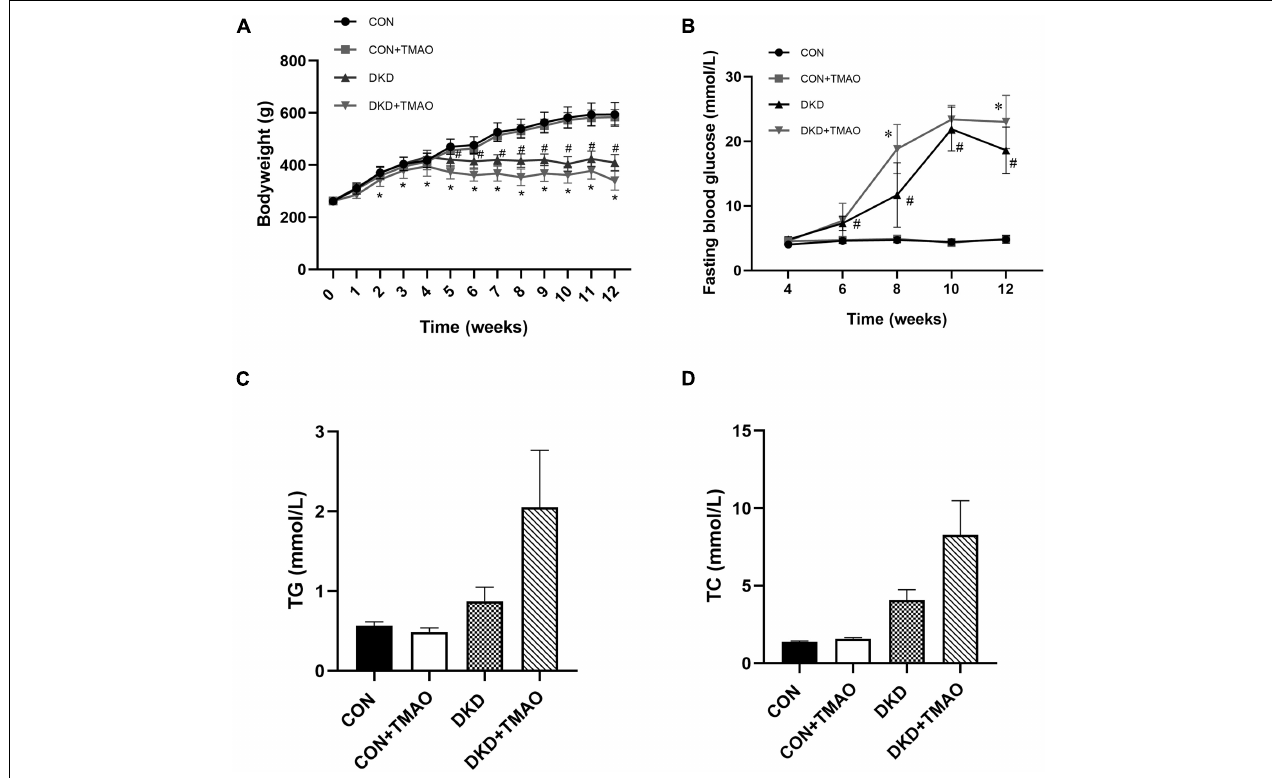
FIGURE 2 | Body weight and metabolic parameters in rats. (A) Body weight, (B) Fasting blood glucose, (C) Cholesterol, (D) Triglyceride. Data are presented as mean ± SEM ( n = 8 for each group). # P < 0.05 vs. CON, ∗ P < 0.05 vs.